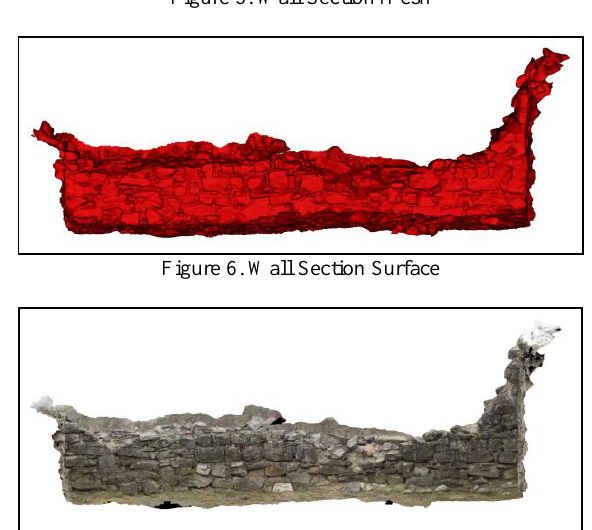
Figure 5. Wall Section Mesh